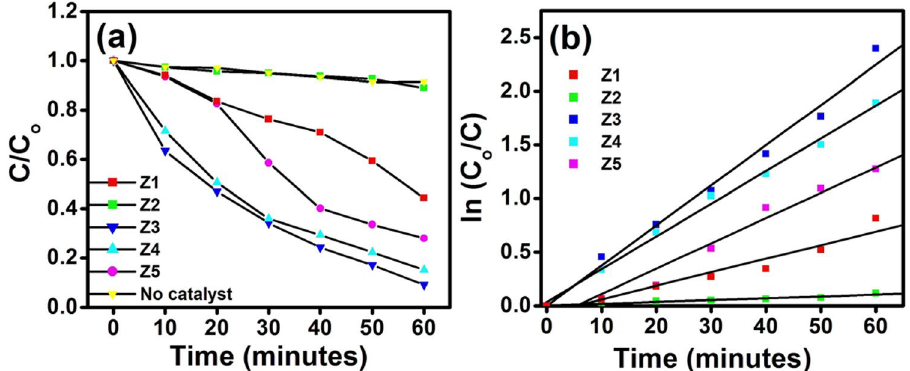
Fig. 6 a Comparison and b kinetics of Photo-degradation of p –nitrophenol under light illumination containing differ- ent photocatalyst